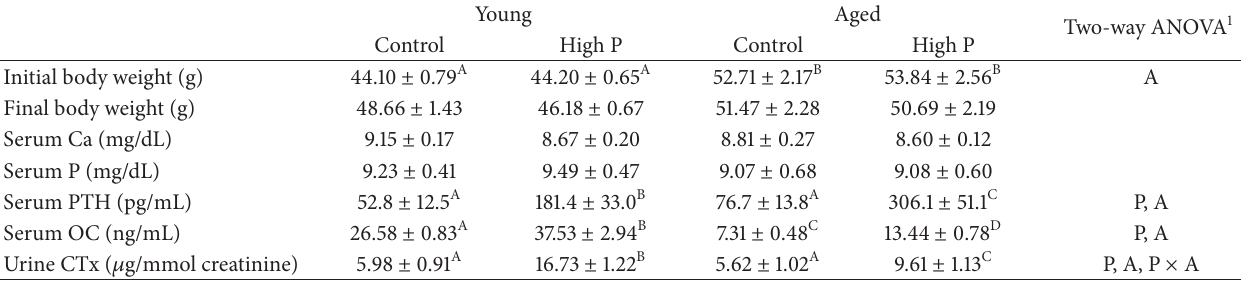
Table 2: Body weight, serum Ca and P, serum PTH, and markers of bone